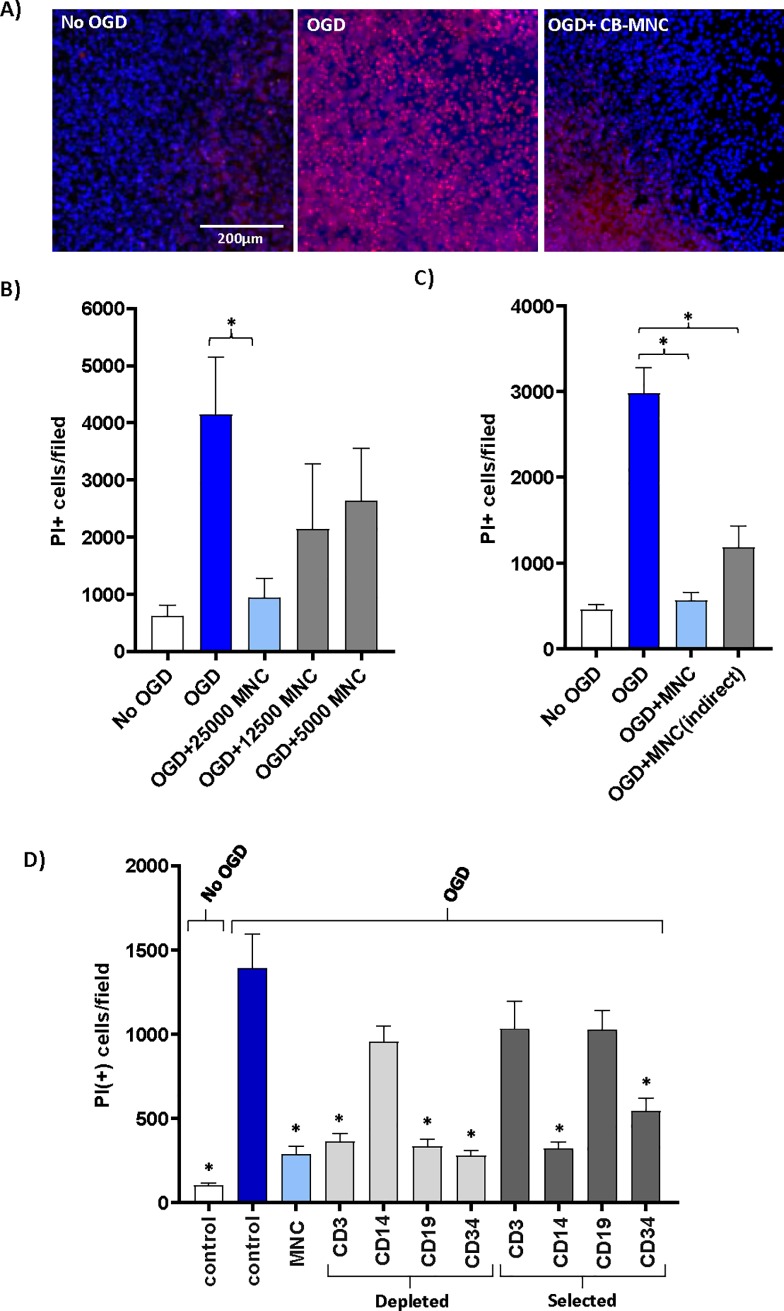
Human cord blood mononuclear cells reduce death of mouse forebrain cells following OGD shock.A) Left panel shows slice cultures not exposed to OGD. Slices in other panels were exposed to OGD for one hour, returned to normoxic, glucose replete conditions, and then cultured for 72 hours after which cell viability was assayed by staining with DAPI (blue) and PI (red). Middle panel shows slices cultured without added CB cells. Right panel shows slices cultured with 25,000 CB-MNC added directly onto slice at the end of OGD. B) Protection of brain cells following OGD depends on dose of CB-MNC added to slices. PI-stained cells were counted in contiguous 10X high power fields in the periventricular region. Bar graphs show mean +/- SE of PI-stained cells per 10X high-power filed. Only the 25,000 cell dose group showed protection (n = -3, one way ANOVA, * p≤0.001). C) Paracrine factors from CB-MNC protect brain slice cultures after OGD shock. CB MNC were added either onto slice (light blue bar, 2.5x104 cells) or in medium below membrane (grey bar, 1.25x105 cells; n = 3, one way ANOVA, * p<0.01). D) OGD-shocked slices were co-cultured with CB-MNC that had been immunomagnetically depleted of the specific subpopulations or were co-cultured with immunomagnetically selected subpopulations expressing the surface antigen shown. First column on the left shows normoxic controls. All other data from OGD shocked slices (one-way ANOVA; *p<0.001).